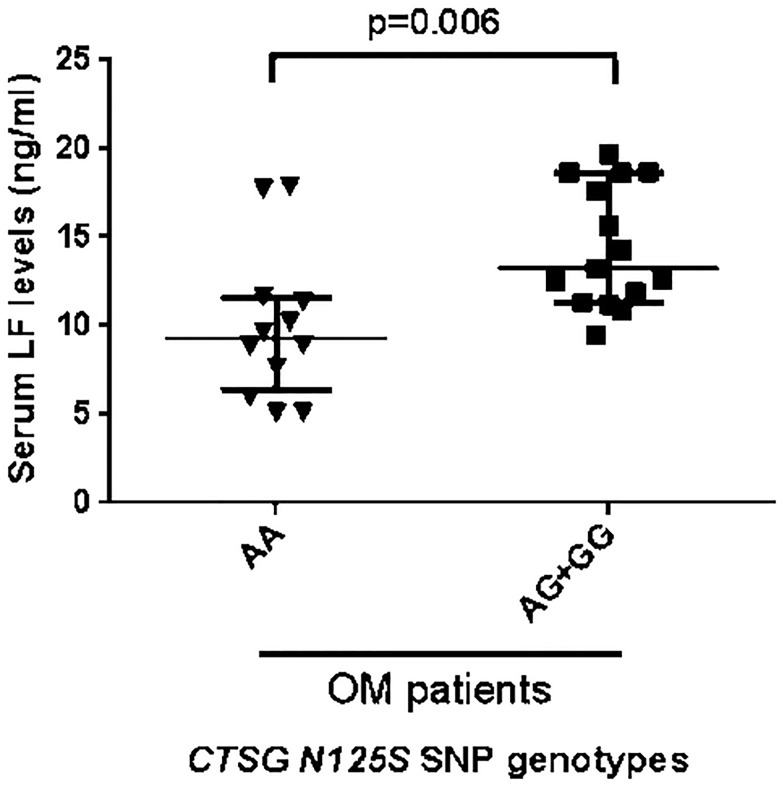
Serum Lactoferrrin (LF) levels in patients with acute osteomyelitis according to their alleles of CTSG (rs 45567233).Lactoferrin (LF) was measured in serum of osteomyelitis patients by an ELISA assay. Results from individual AA subjects are shown as inverted triangles and AG + GG subjects as squares. The long horizontal bars are the median values and shorter bars show IQR.